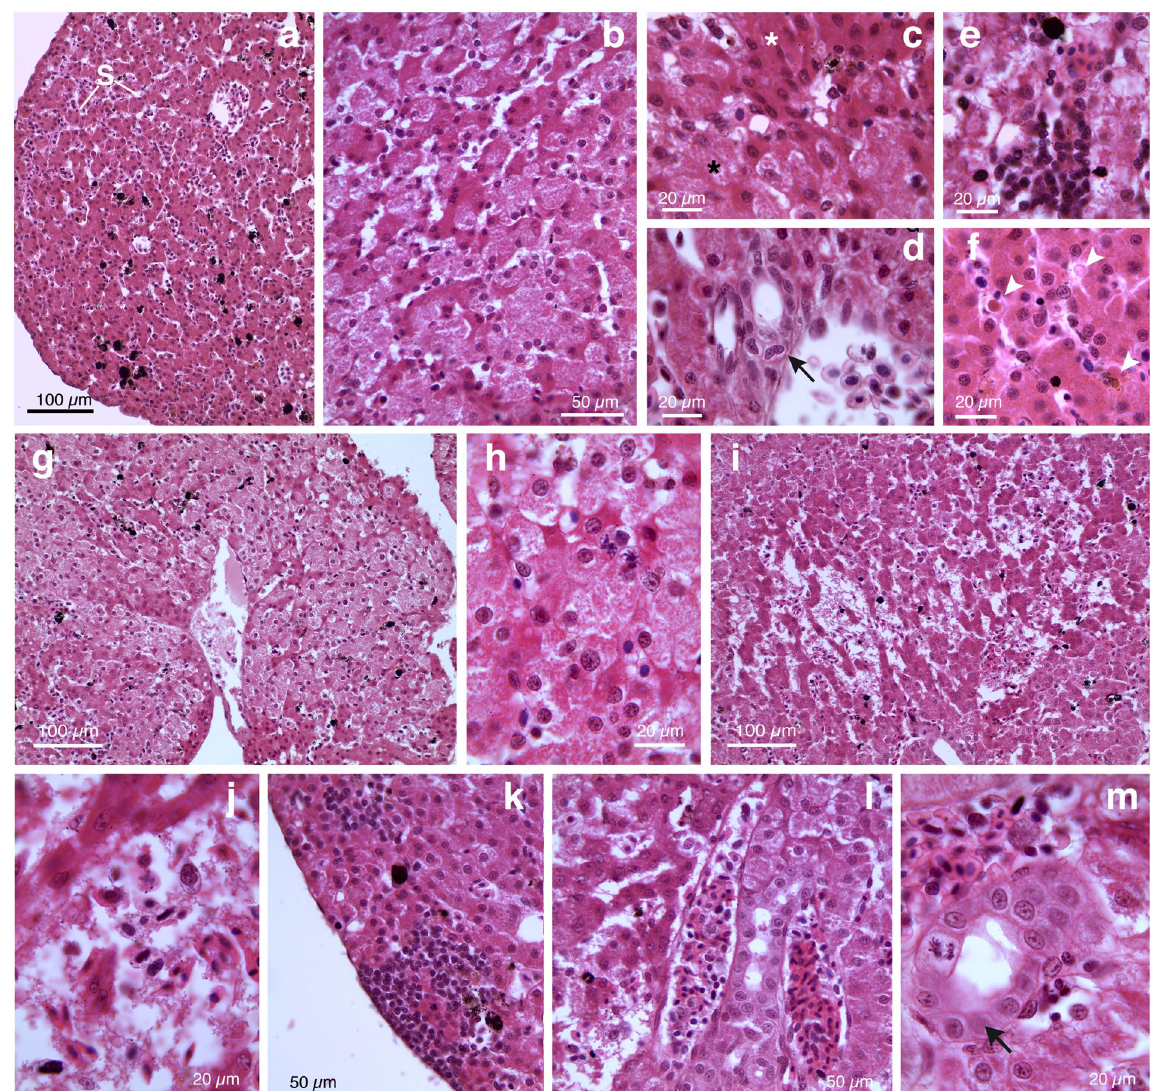
Figure 6. Histopathological examination of liver tissue in H . intermedia juveniles after chronic exposure to pyrimethanil. ( a – f ) Representative light micrographs showing alterations in H . intermedia liver after exposure to 5 µ g/L of pyrimethanil. ( a ) Congestion and dilatation of sinusoids (S). ( b ) Liver parenchyma dyschromia. ( c ) Necrotic cells with pale cytoplasm (white asterisk) and apoptotic cells (black asterisk) with a hypereosinophilic cytoplasm. ( d ) Degenerating bile ducts (arrow). ( e ) Mononuclear cells infiltration. ( f ) Apoptotic cells (arrowheads). ( g – m ) Representative light micrographs showing the alterations observed in H . intermedia liver after exposure to 50 µ g/L of pyrimethanil. ( g ) Note the diffuse and extensive degenerative phenomena in liver parenchyma. ( h ) Particular at higher magnification of hepatocytes in degeneration. ( i , j ) Hepatic parenchyma completely disorganized in which is possible to note extended necrotic and hemorrhagic zones. ( k ) Mononuclear cell infiltration. ( l ) Blood vessels congestion. ( m ) Note the disorganization in bile ducts (arrow). All cross-sections are